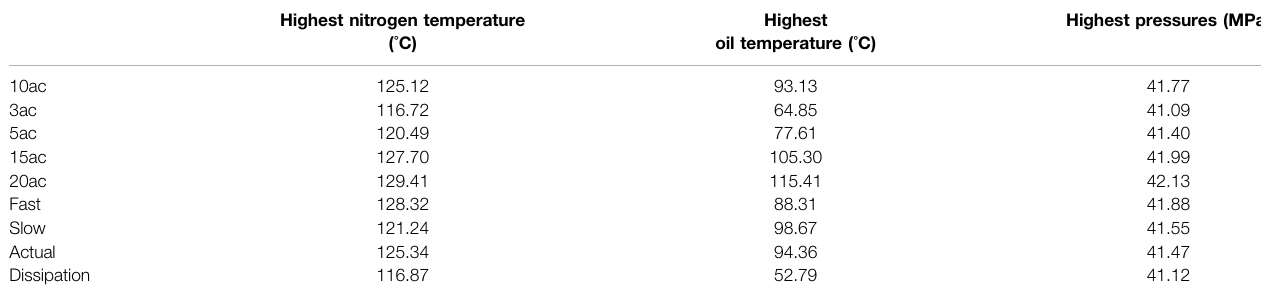
TABLE 4 | Highest temperatures and pressures in different